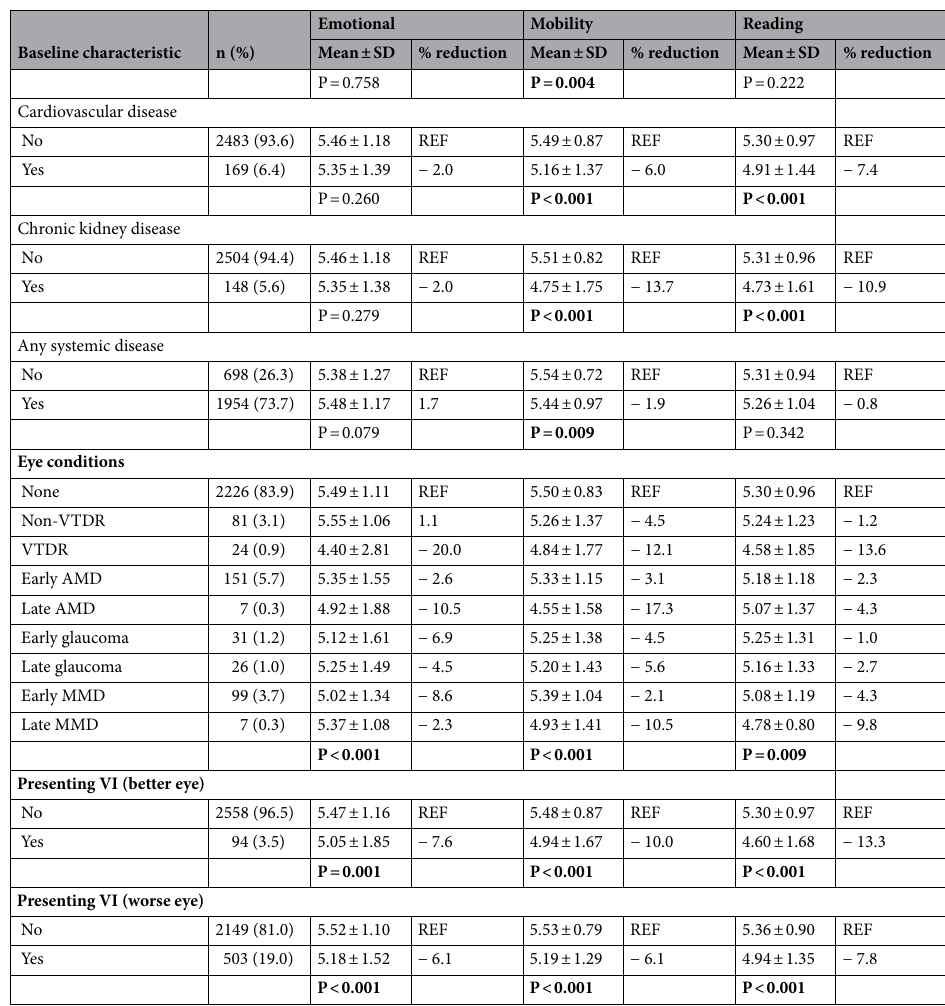
Table 1. Comparison of IVI scores by sociodemographic and clinical characteristics (N = 2652). Systemic diseases include: diabetes mellitus, arterial hypertension, hyperlipidaemia, cardio vascular disease and chronic kidney disease. Significant values are in [bold]. BMI body mass index, VTDR vision-threatening diabetic retinopathy, AMD age related macular degeneration, MMD myopic macular degeneration, VI visual impairment, REF